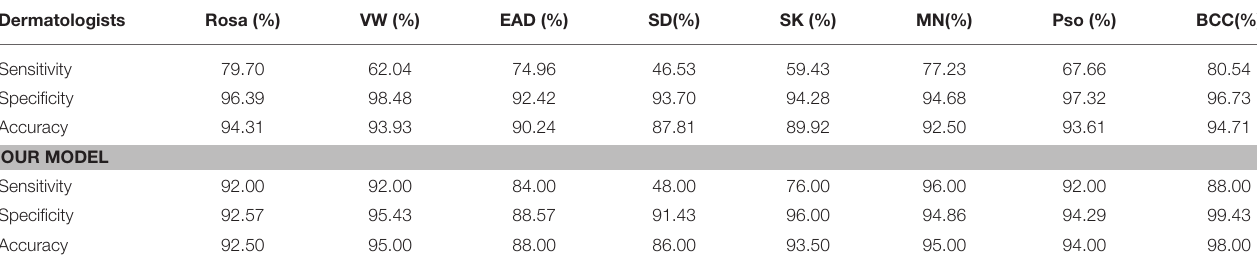
TABLE 4 | Comparison between doctors and our CNN model in an 8-class task, the better outcomes of our CNN model are colored orange. Dermatologists